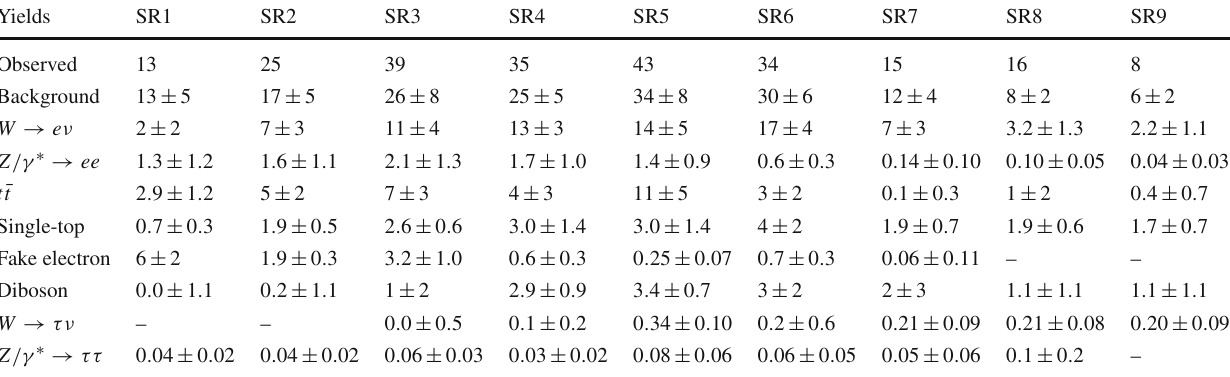
Table 10 Event yields in the signal regions of the e ν J channel. Data are shown together with the background contributions after a combined background-only fit in the control and signal regions Yields SR1